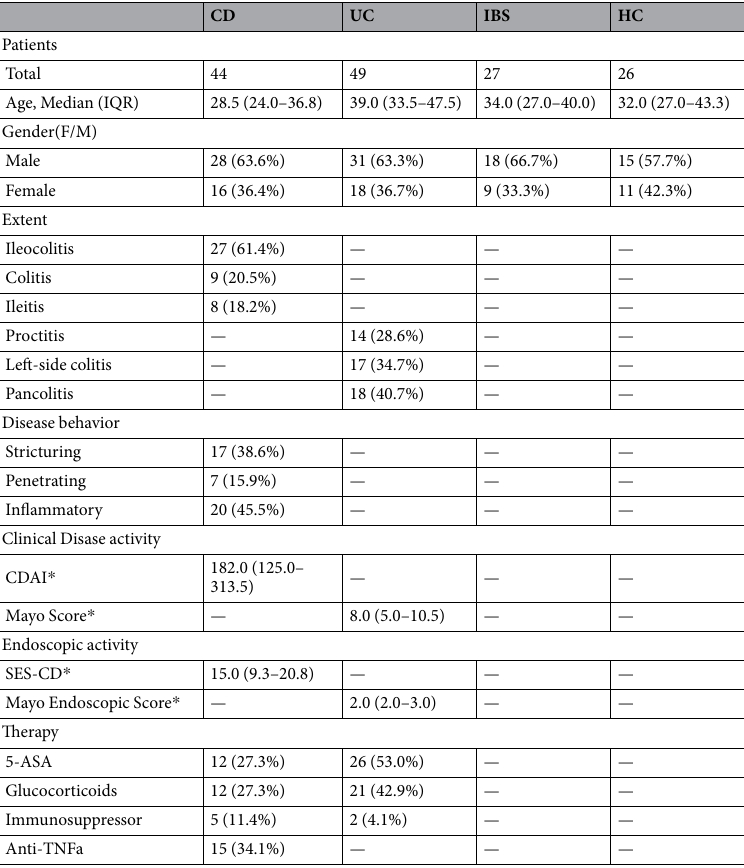
— — — Table 1. Baseline characteristics of study patients. Median (IQR)for continuous variables; IQR, interquartile range; HC, healthy controls; IBS, irritable bowel syndrome; SES-CD, simplified endoscopic score for Crohn’s disease; CDAI, Crohn’s Disease Activity